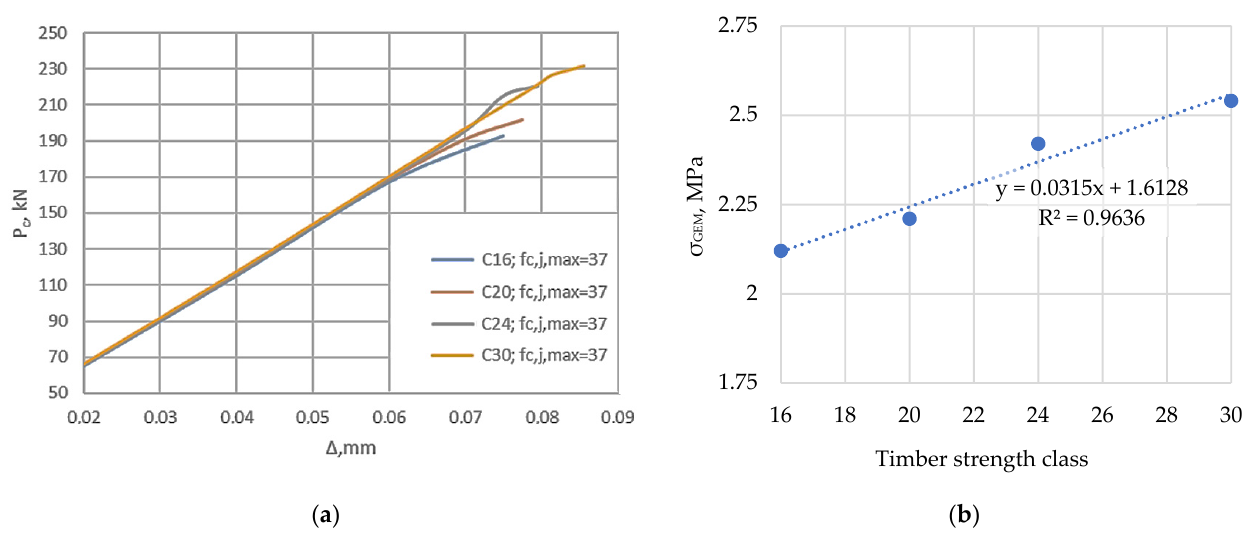
Figure 13. Influence of the wood strength classes on the behaviour of cordwood: ( a ) force/defor- mation curves for the cordwood specimen differed with the wood strength classes; ( b ) compressive strength of cordwood as a function of the strength classes of the wood.